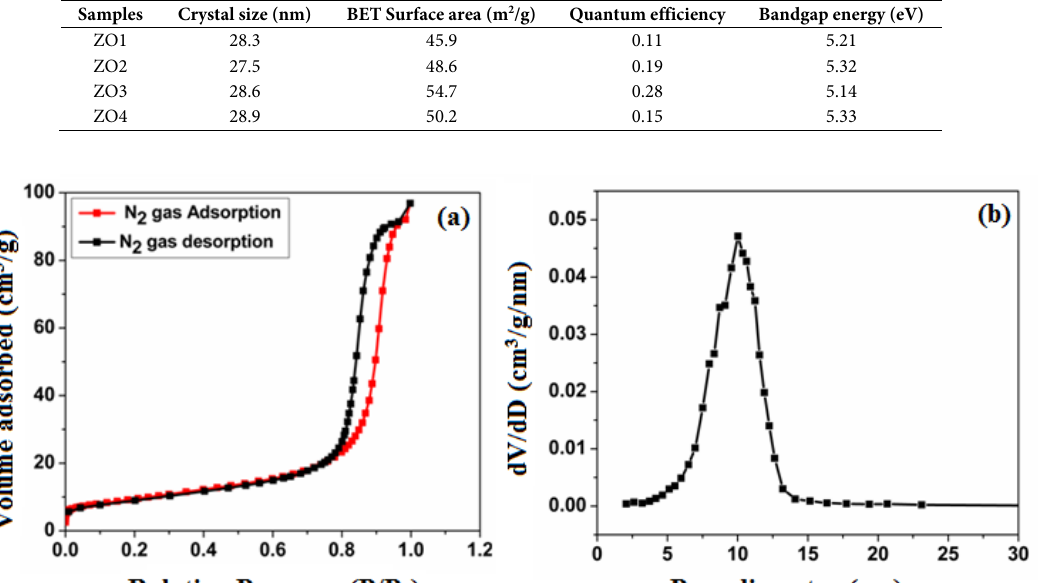
Barret-Joyner-Halenda (BJH) pore size distribution plot of 2